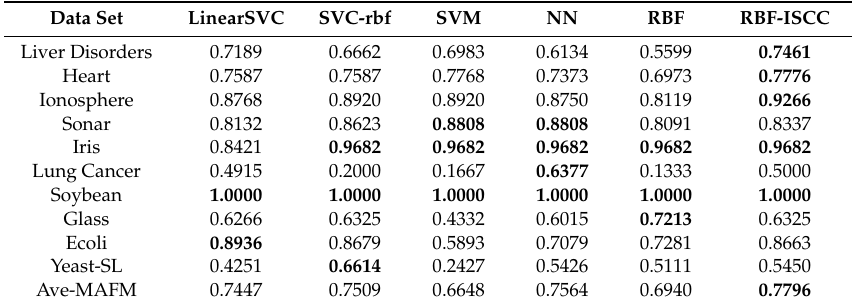
Table 3. Testing macro-averaged F-measure (MAFM) obtained for single-label data sets.